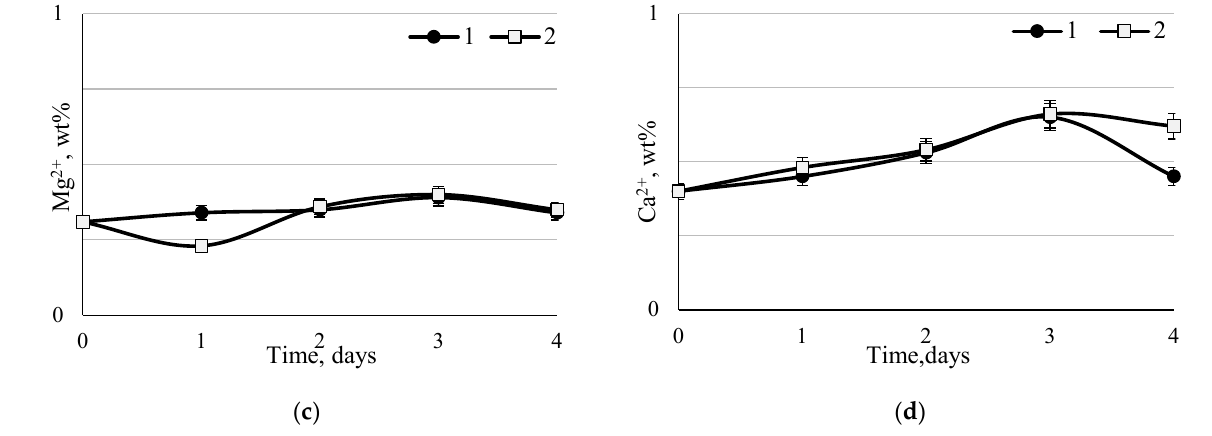
Figure 2. Dynamics of the content of macronutrients ( a ) potassium cations; ( b ) sodium cations; ( c ) magnesium ions; ( d ) calcium cations during SBM fermentation for different hydromodules (SBM:water): 1—30:110; 2—30:130.